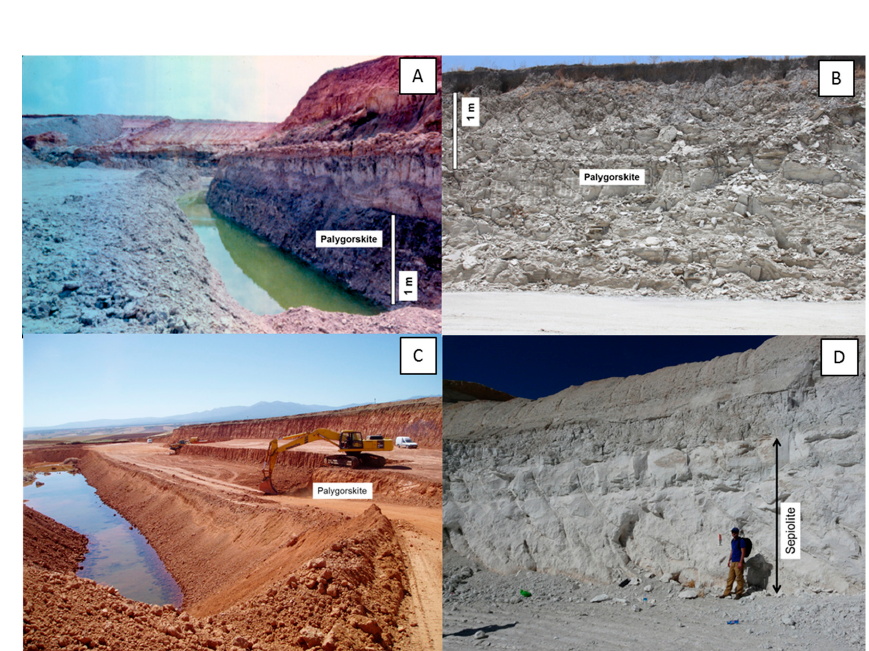
Figure 4. Quarry fronts from different Mg-clay deposits. ( A ) Florida-Georgia palygorskite deposit at Quincy (USA). ( B ) Thies-Allou Kagne palygorskite deposit (Senegal). ( C ) Bercimuel palygorskite deposit (Duero Basin, Spain). ( D ) Bedded sepiolite in the Eskisehir deposit (Turkey).